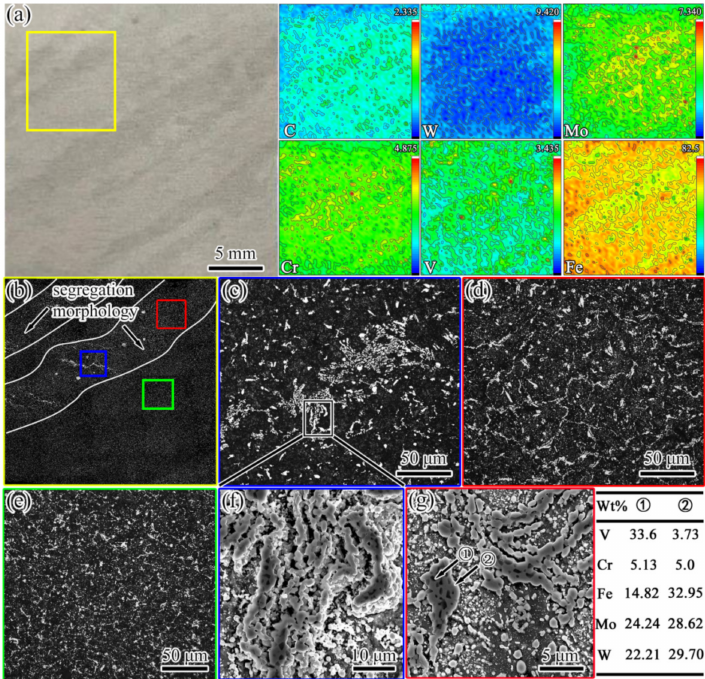
Figure 5. Images from the composition test and microstructure observations of sample #6. ( a ) The segregation morphology and alloying element distribution; the values in the top-right corner of each figure indicate the maximum concentration (red); ( b ) the microstructure (OM) of the area in the yellow box in ( a ); ( c – e ) the microstructures (OM) in the blue, red, and green boxes in ( b ), respectively; ( f ) the SEM image of carbide segregation bands corresponding to ( c ); ( g ) the SEM image of the network-like carbide.